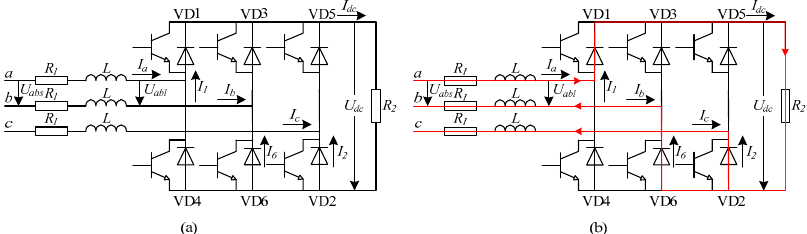
Figure 3. The equivalent circuit for analysis: ( a )The simplified circuit model of VSC; ( b ) The current path and direction.